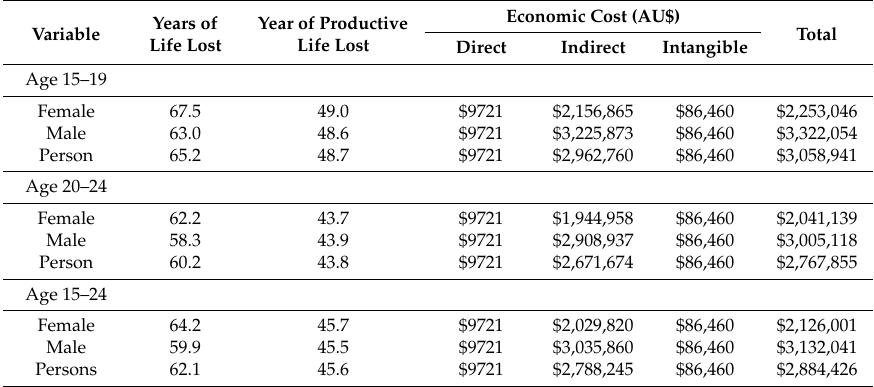
Table 3. The economic cost of a single youth suicide, Australia, 2014, by age and sex.